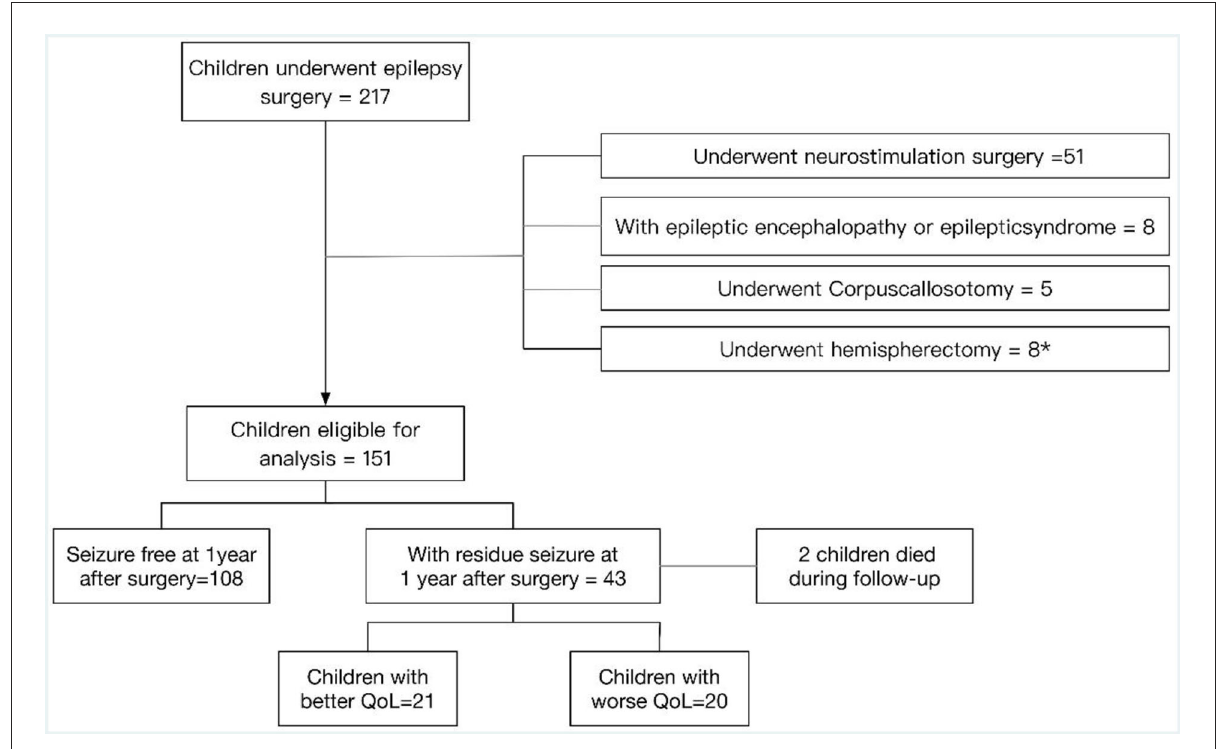
FIGURE1 Patient selection flowchart. *Six of the eight children who underwent hemispherectomy were diagnosed with epilepsy